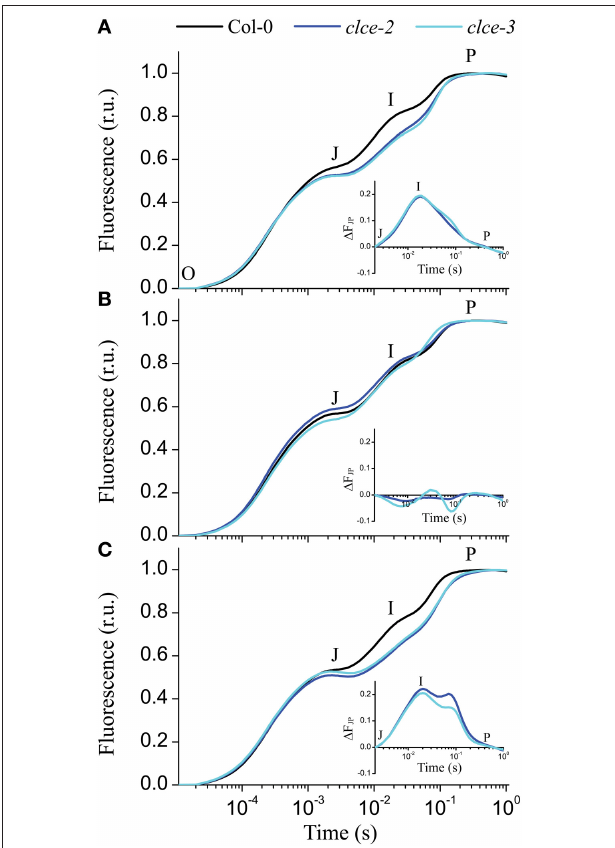
FIGURE 5 | Fast chlorophyll a fluorescence OJIP transients of untreated and salt-treated leaves. Detached wild-type and mutant leaves that have been incubated in the light for 30min in water (A) , 150mM KCl (B) , or 150mM KNO 3 (C) were removed from the solution and were dark adapted for 15min before OJIP transients were recorded. The transients were double normalized to F 0 and F m . The time points for the calculation of the OJIP parameters are marked: O —the fluorescence intensity at 50 µ s, J —at 2ms, I —at 30ms, and P —the maximum fluorescence intensity. Insets in each plot show the curve difference of double normalized data at J and P ( 1 F JP ) between wildtype and each of the clce mutants. The plotted data are means ± SEM ( n = 5 plants).